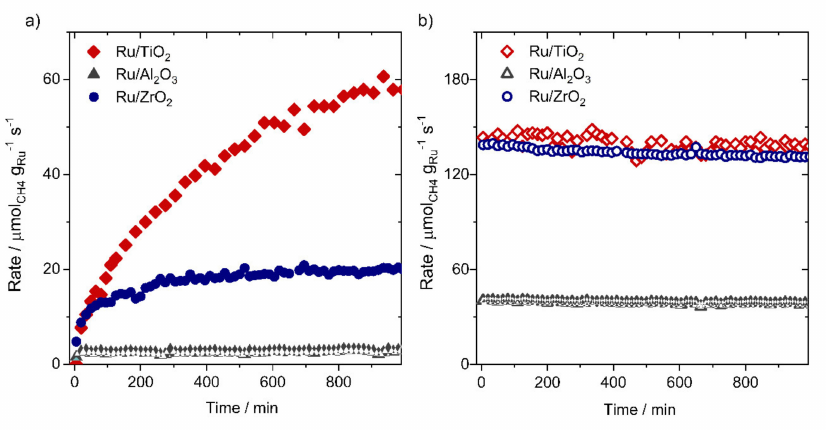
Figure 4. ( a ) Time-on-stream CO 2 methanation reaction rate recorded on Ru/TiO 2 [66], Ru/ Al 2 O 3 [67], and Ru/ZrO 2 [71] during CO 2 methanation after oxidative treatment in 10% O 2 /N 2 at 150 ◦ C for 30 min (O150), and ( b ) after high temperature reaction treatment (TPR:190 to 350 ◦ C). All catalytic measurements on these catalysts were done on powder samples using 200 mg of Ru/MO x catalyst diluted by thermally stable and catalytically inactive α –Al 2 O 3 (1:10–Ru/MO x : α –Al 2 O 3 ) using a flow of 41.6 Nml min − 1 at constant GHSV. Data in this figure are produced from Refs